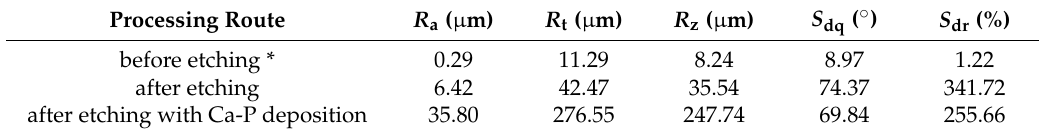
Table 3. 2D ( R a , R t , R z ) and hybrid ( S dq , S dr ) parameters for the Ti23Mo 3BG nanocomposite on different processing routes; parameters taken from surface area of 1.08 mm 2 .